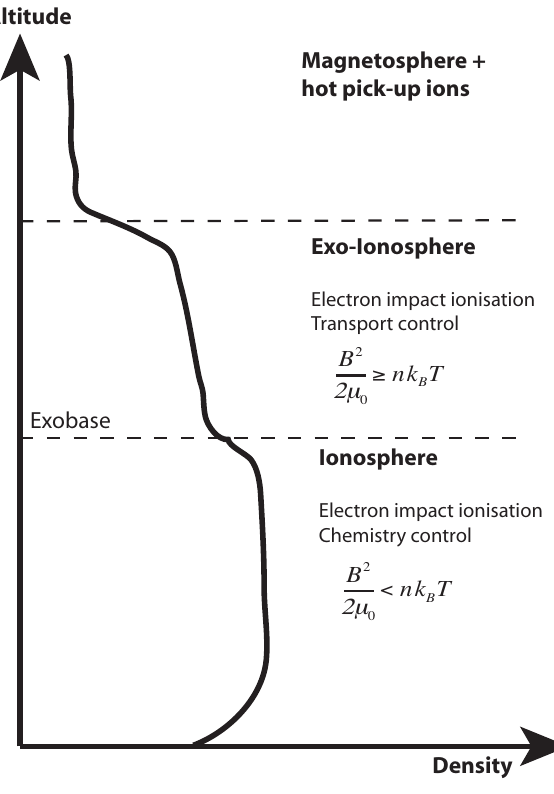
Fig.13. CartoonofTitan’sionosphereduringeclipseconditions. Thesharperboundarysignaturesarecausedby themagnetosphericinteractionwiththecoldanddenseionosphericplasma. DuringtheT5flybytheionopause Fig. 13. Cartoon of Titan’s ionosphere during eclipse conditions. coincide with the exobase, which is not necessarily the case at other flybys. In the ionosphere the magnetic The sharper boundary signatures are caused by the magnetospheric pressurecanbecomecomparabletothethermalpressure. interaction with the cold and dense ionospheric plasma. During the T5 flyby the ionopause coincide with the exobase, which is not nec- essarily the case at other flybys. In the ionosphere the magnetic pressure can become comparable to the thermal